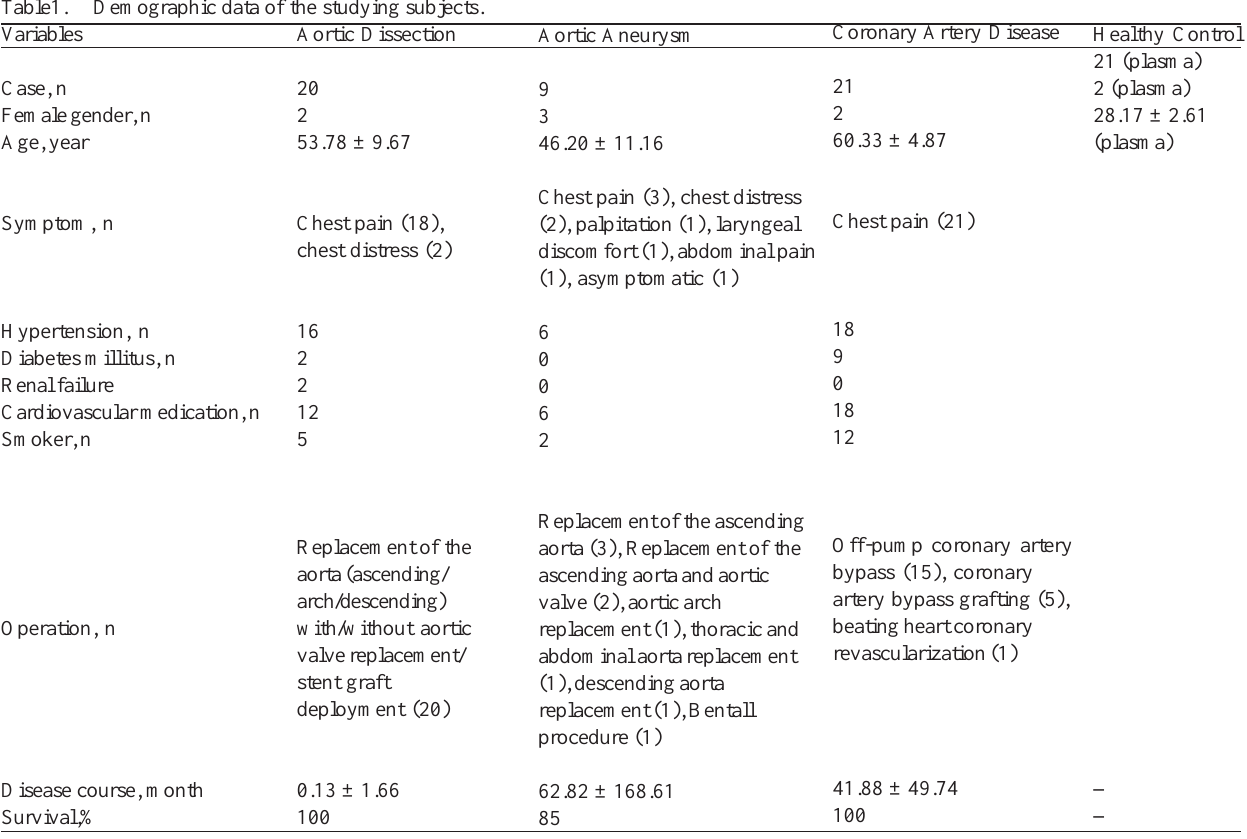
Table1. Demographic data of the studying